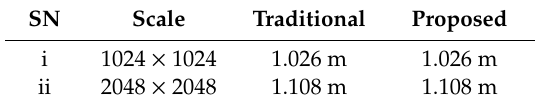
Table 5. The mean errors of the three-dimensional geolocation for check points.